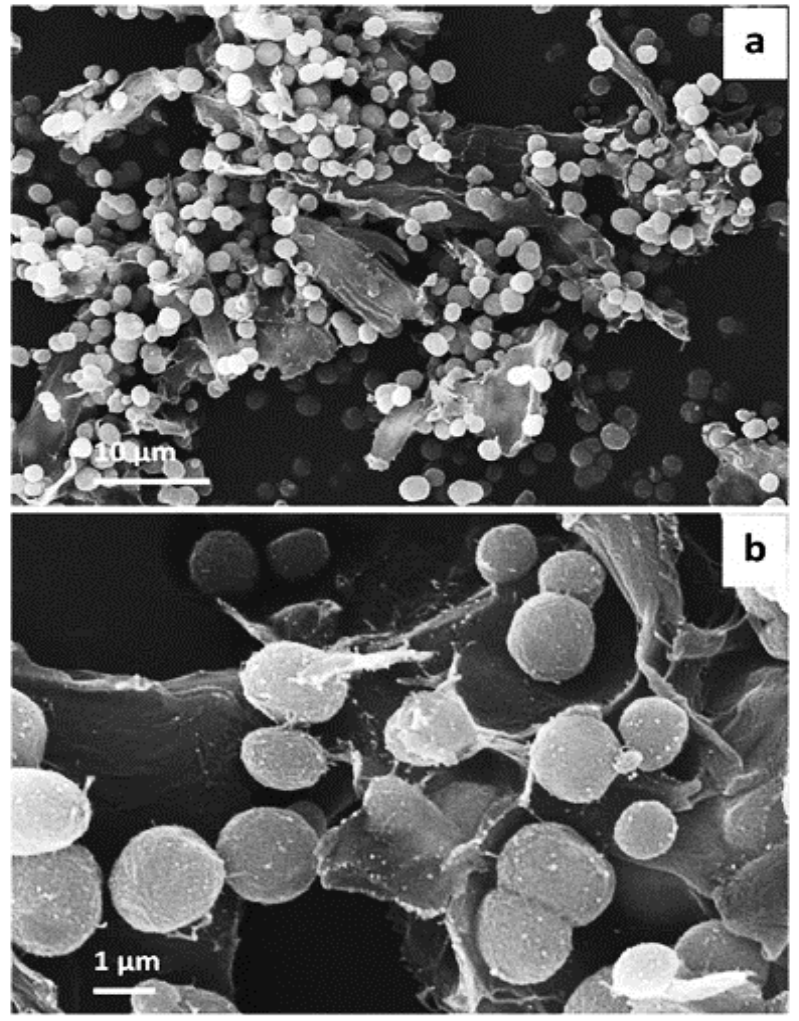
Figure 7. Representative SEM images showing ( a ) the overview of MFC coated with CaCO 3 crystals in water and ( b ) enlarged surface of MFC-CaCO 3 . The Figure was adapted with permission from [32].